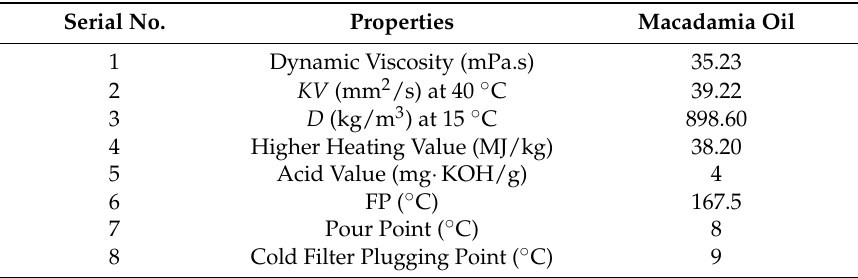
Table 3. Properties of crude macadamia oil.